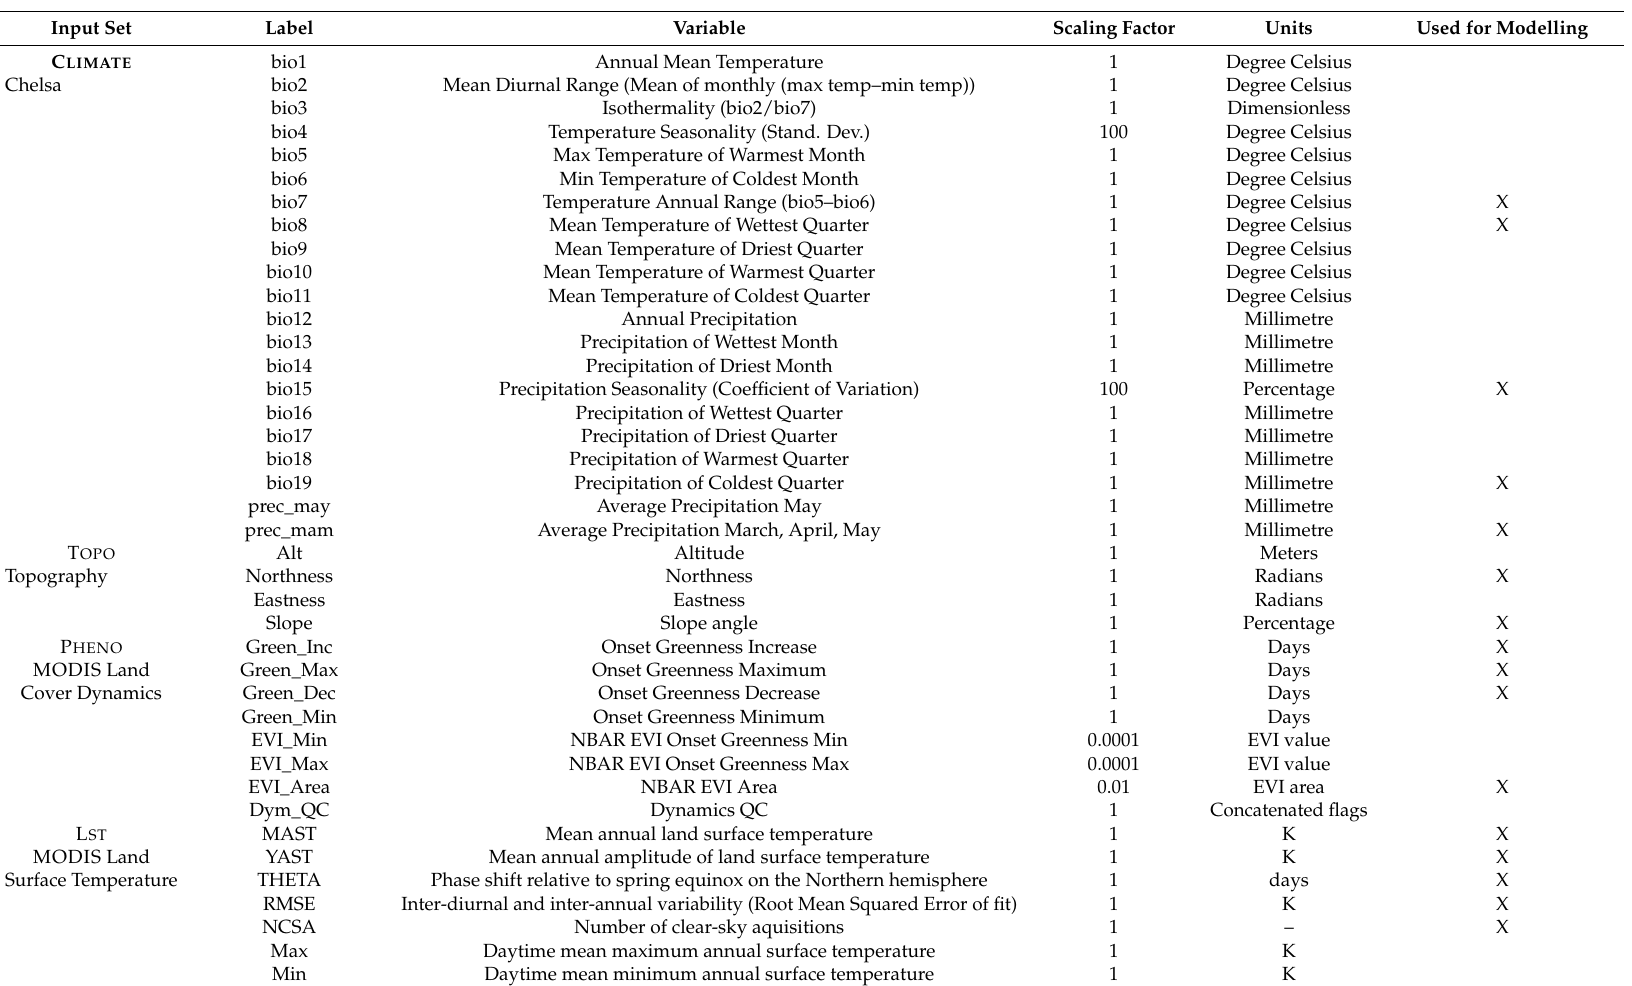
Table 1. Predictor sets with variables used for modelling the ecological niche of Betula utilis